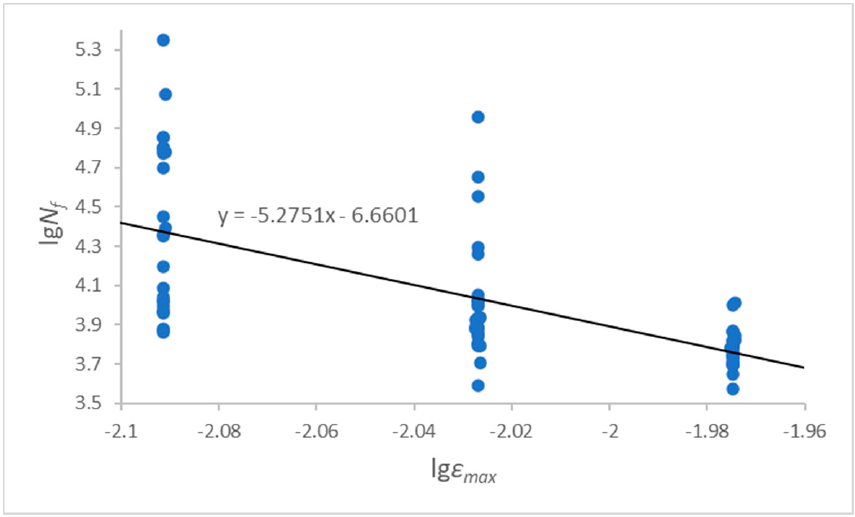
Figure 7. Fitting of damage parameters when R = 0.2.